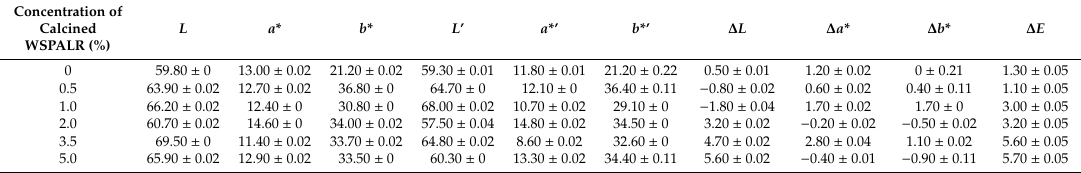
Table 4. E ff ect of high-temperature calcined WSPALR on the color di ff erence of waterborne coatings. Concentrationof Calcined